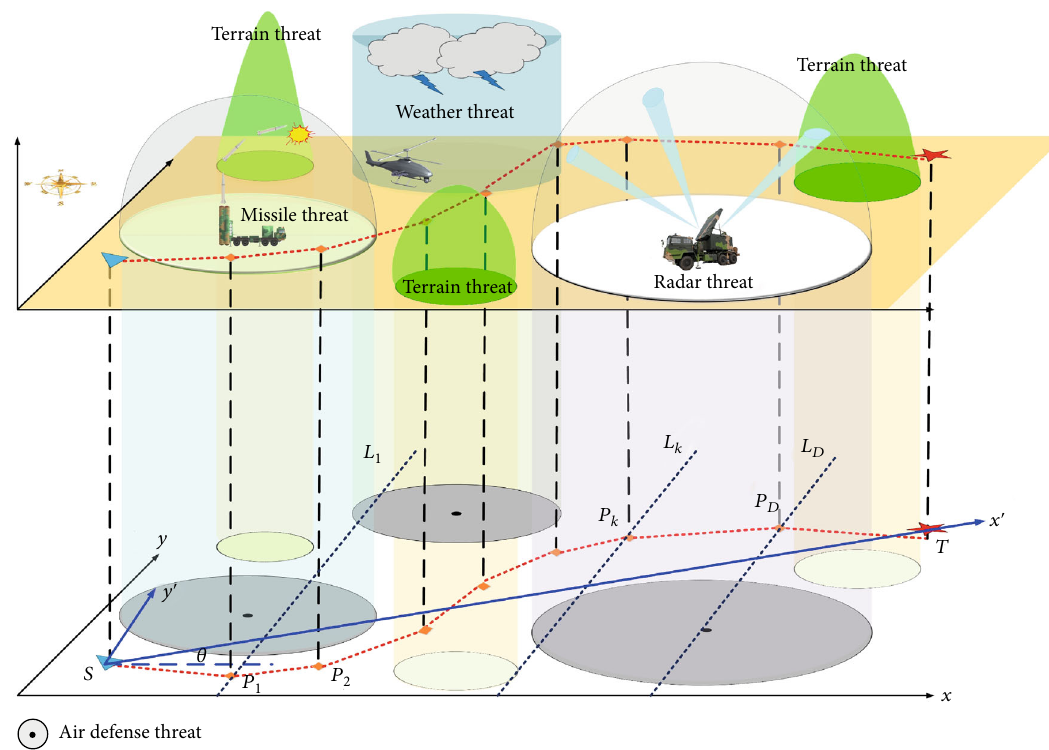
Figure 2: Schematic of 2D UAH battle fi eld